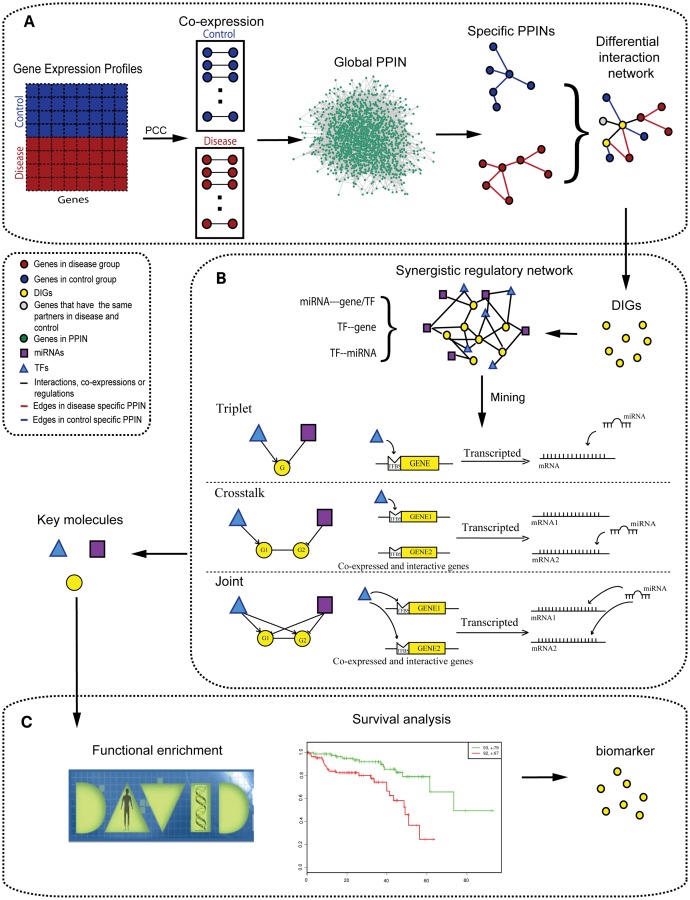
Flow diagram of this work.Detection of differential interaction genes. The gene expression profiles were separated into disease and control groups. The co-expressed gene pairs were then obtained from Pearson correlation coefficient (PCC). The gene pairs were mapped to global protein-protein interaction network (PPIN) to obtain specific PPINs. Finally, the two specific PPINs were merged to a differential interaction network (DIN) to detect DIGs. (B) Excavation of the three co-regulatory motifs. MiRNA&TF co-regulated relationship were introduced to our DIGs to construct a miRNA&TF synergistic regulatory network. Three kinds of motifs (triplet, crosstalk, and joint) were mined in the network. (C) Identification of biomarker. Key molecules were detected from the motifs. Functional enrichment and survival analysis were applied to gain biomarker.